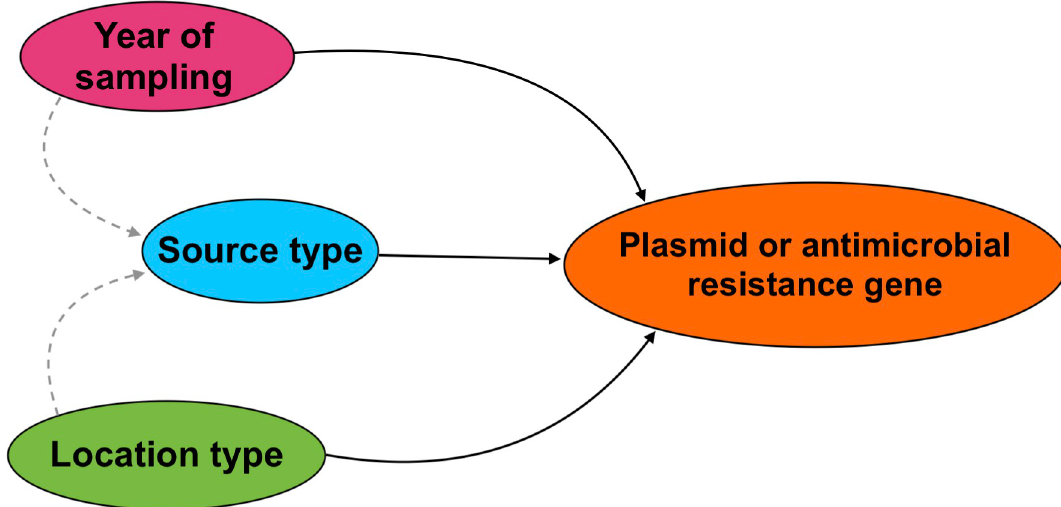
Fig 2. Causal diagram illustrating the relationships between source type, location type, year of sampling, and the carriage of predicted plasmids and antimicrobial resistance genes in Escherichia coli isolates collected from wildlife, swine manure pits, and environmental sources in southern Ontario, 2011 − 2013. Solid lines show directionality of proposed relationships between dependent and independent variables. Dashed grey lines show potential confounding relationships.